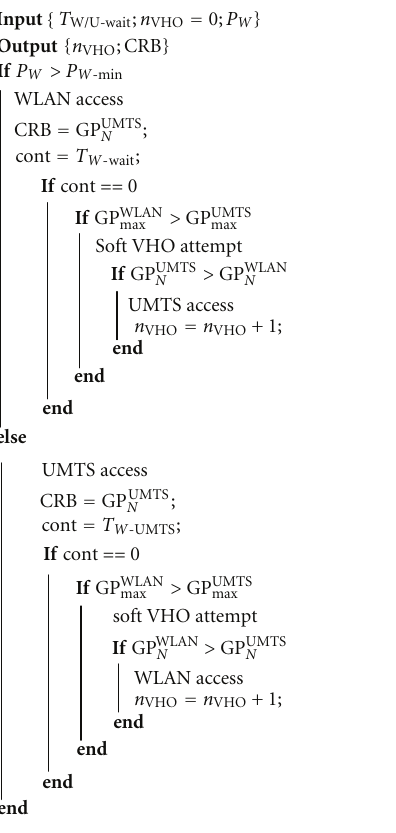
Figure 3: Pseudo-code for vertical handover algorithm in ELB- mode.